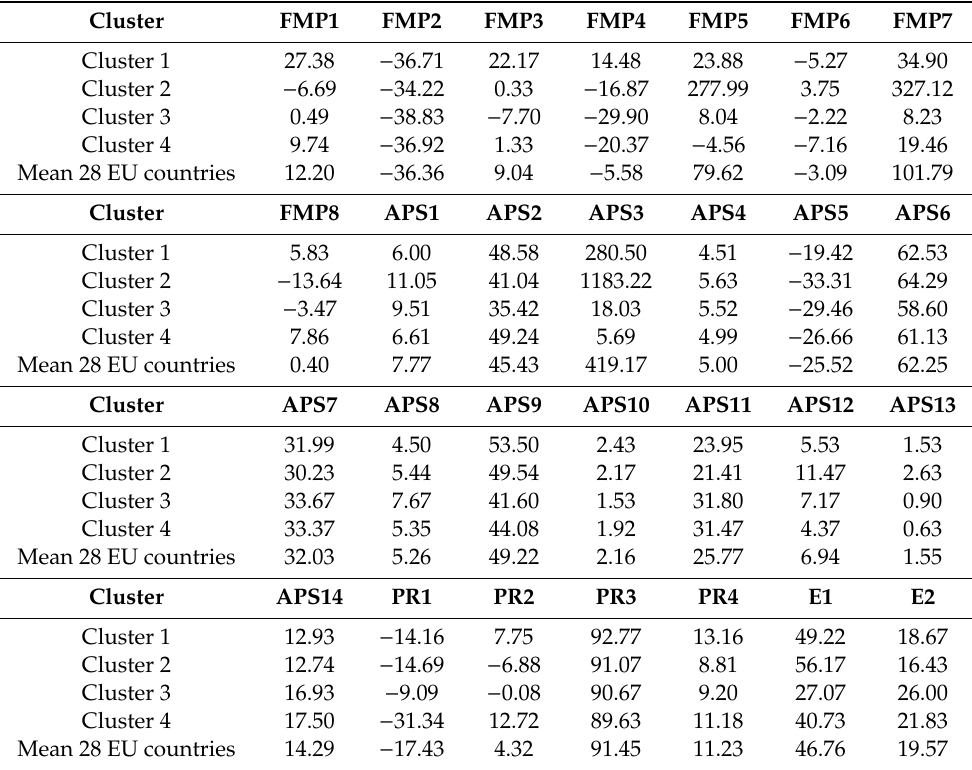
Table 5. Mean of each cluster and mean of the 28 EU